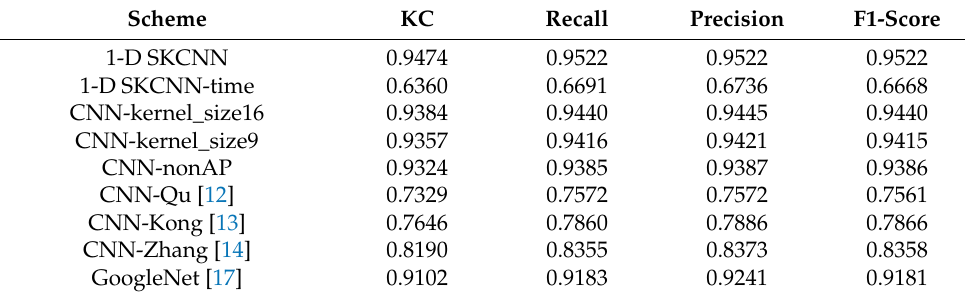
Table 7. The time usage for training the model in different